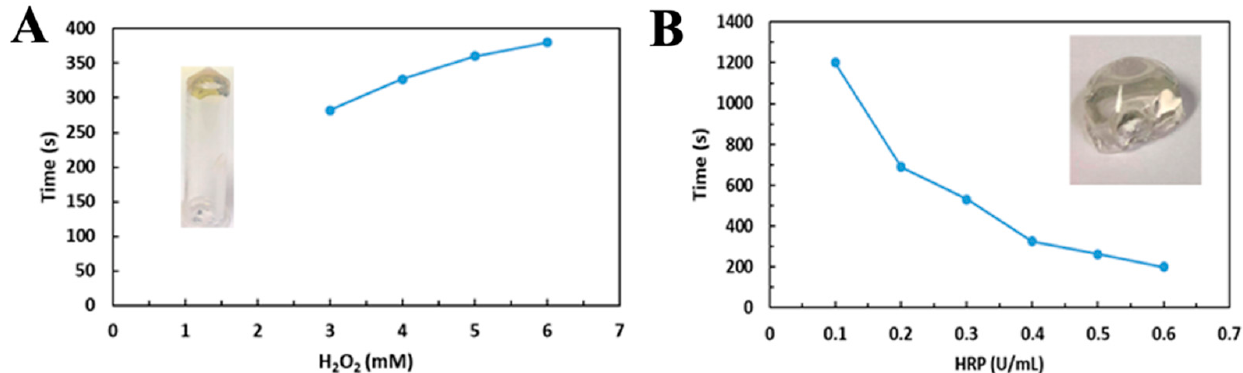
Figure 1. The investigation of gelation conditions of CS-Tyr/gelatin hydrogel. ( A ) Gelation time of 0.5 U HRP/mL and various H 2 O 2 concentrations. ( B ) Gelation time of 3 mM H 2 O 2 and various HRP concentrations.